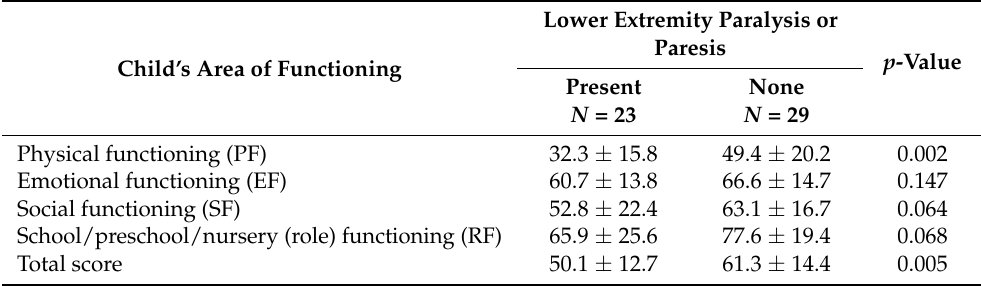
Table 7. Basic statistics (M ± SD) for children’s functioning scores, broken down by the presence or absence of lower extremity paralysis or paresis, with the significance of the test